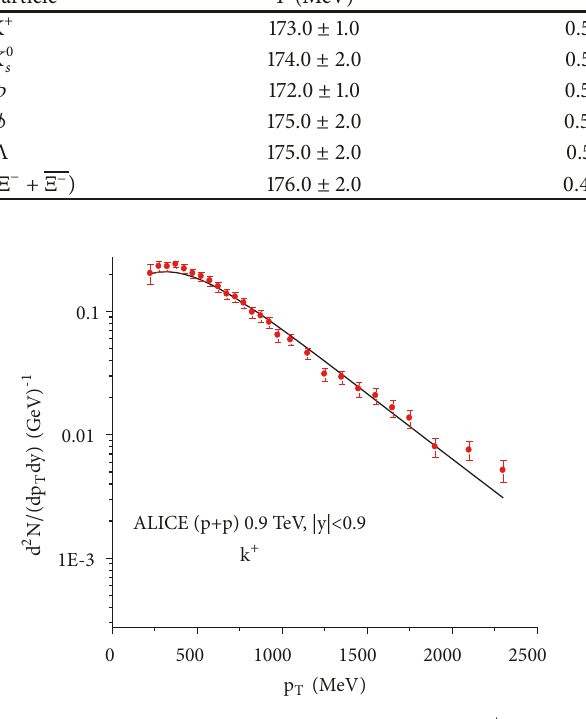
Table 2: Freeze-out parameters of various hadrons along with their corresponding 𝜒 2 /𝑑𝑜𝑓 , produced at √ s NN = 0.9TeV. Particle